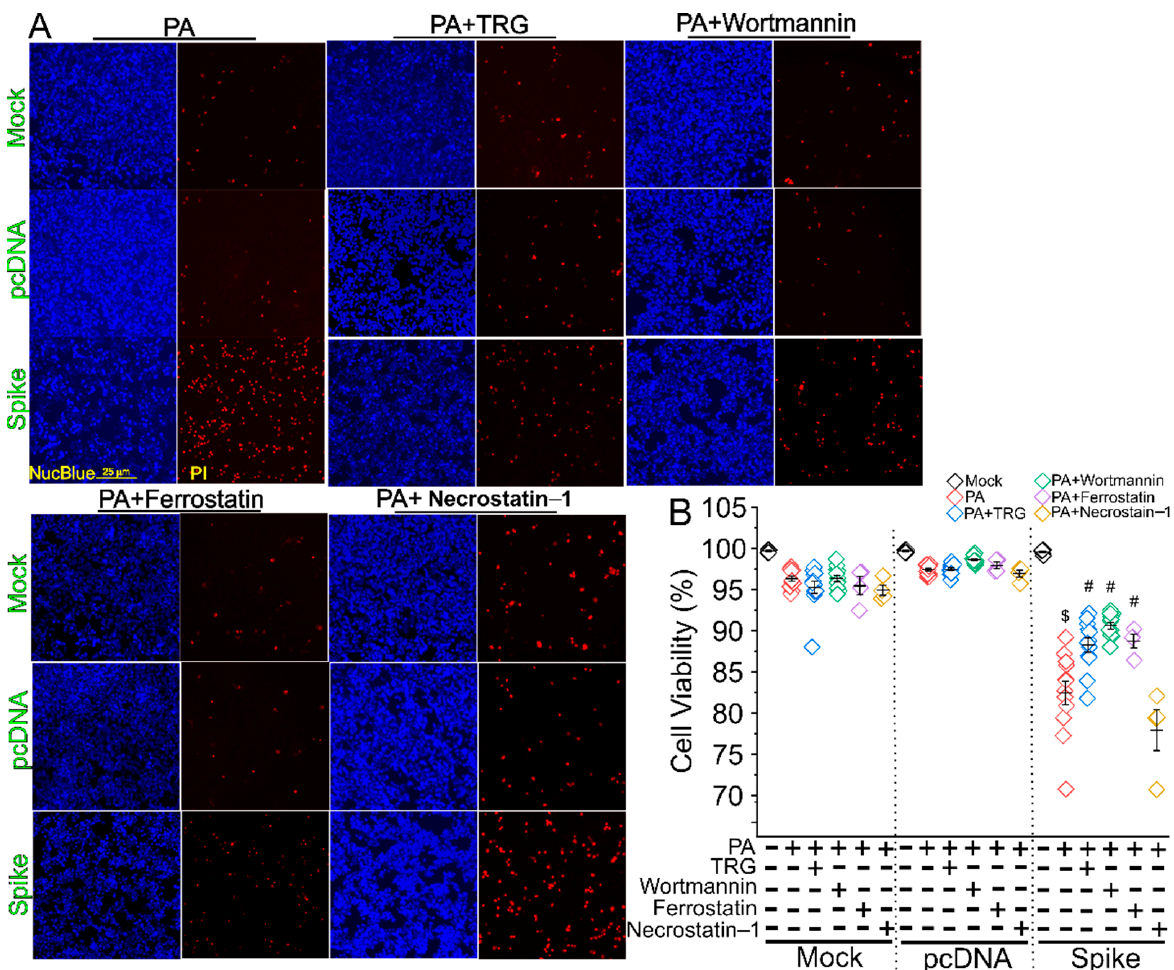
Figure 5. Autophagic/ferroptotic inhibitors attenuated the Spike protein-exaggerated PA-induced necrosis. ( A ) Fluorescent images showing the cell viability in the mock, pcDNA, and Spike cells treated by 750 µM PA treatment for 24 h in DMEM containing 5% FBS with or without a Nrf2 inhibitor TRG, pan-PI3K inhibitor Wortmannin, ferroptosis inhibitor Ferrostain, and apoptotic inhibitor Necrostatin 1. The cells were co-stained by Propidium Iodide (PI) and Hoechst 33342 NucBlue Live Cell Stain dye to show the dead and live cells, respectively. ( B ) Quantitative data showing the cell viability in each treatment group. $ indicates p < 0.05 in the Spike cells treated by PA as compared with the Spike cells without PA treatment. # indicates p < 0.05 in each group treated with PA and various inhibitors as compared with the Spike cells treated with PA only.